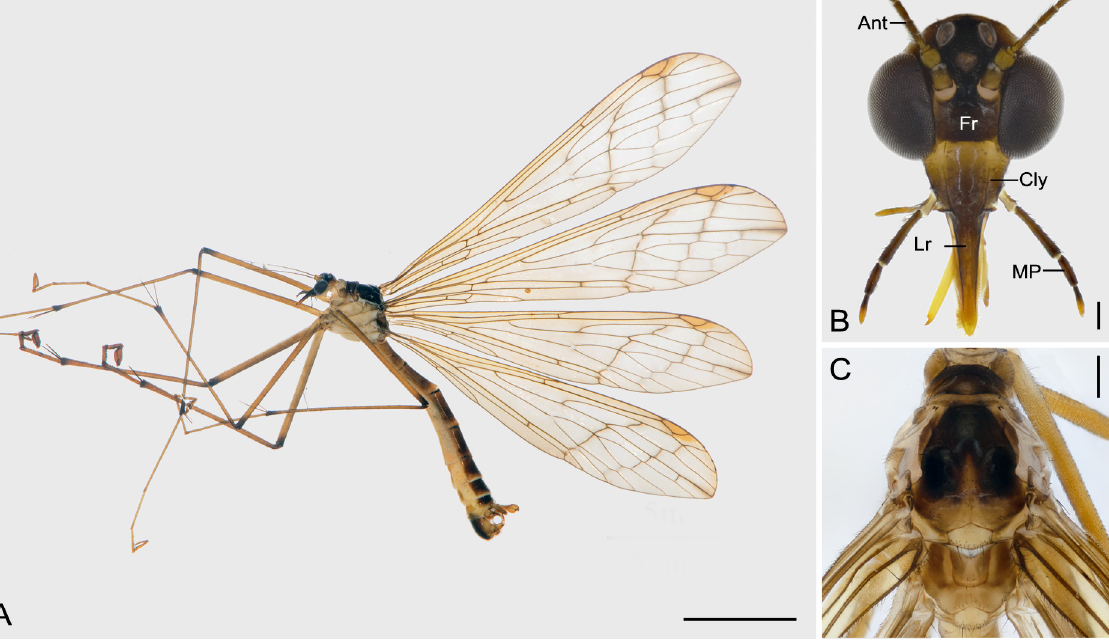
Fig. 5. Terrobittacus angustus sp. nov. A . ♂, habitus in lateral view. B . Head in frontal view. C . Thorax in dorsal view. Abbreviations: Ant = antenna; Cly = clypeus; Fr = frons; Lr = labrum; MP = maxillary palp. Scale bars: A = 5.0 mm; B = 0.2 mm; C =